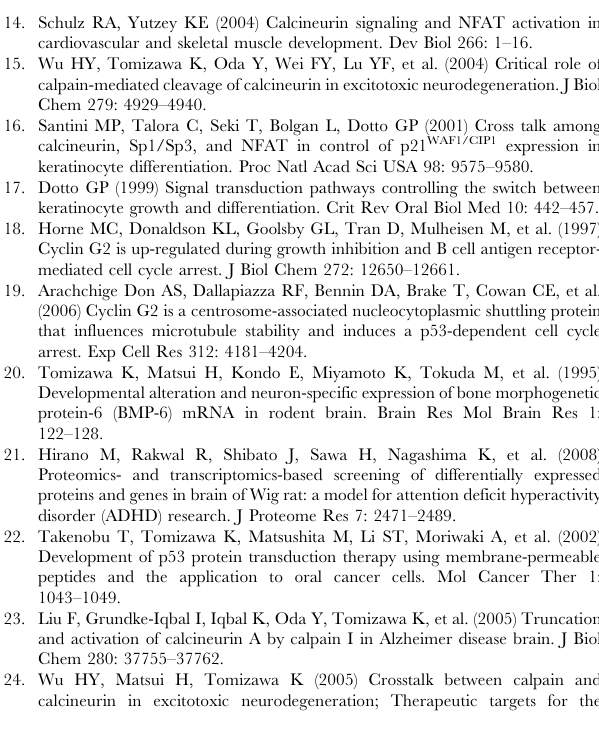
Table S1 Primer sequences for cloning of CnAß-FK. For Table S2 Primer sequences for preparation of